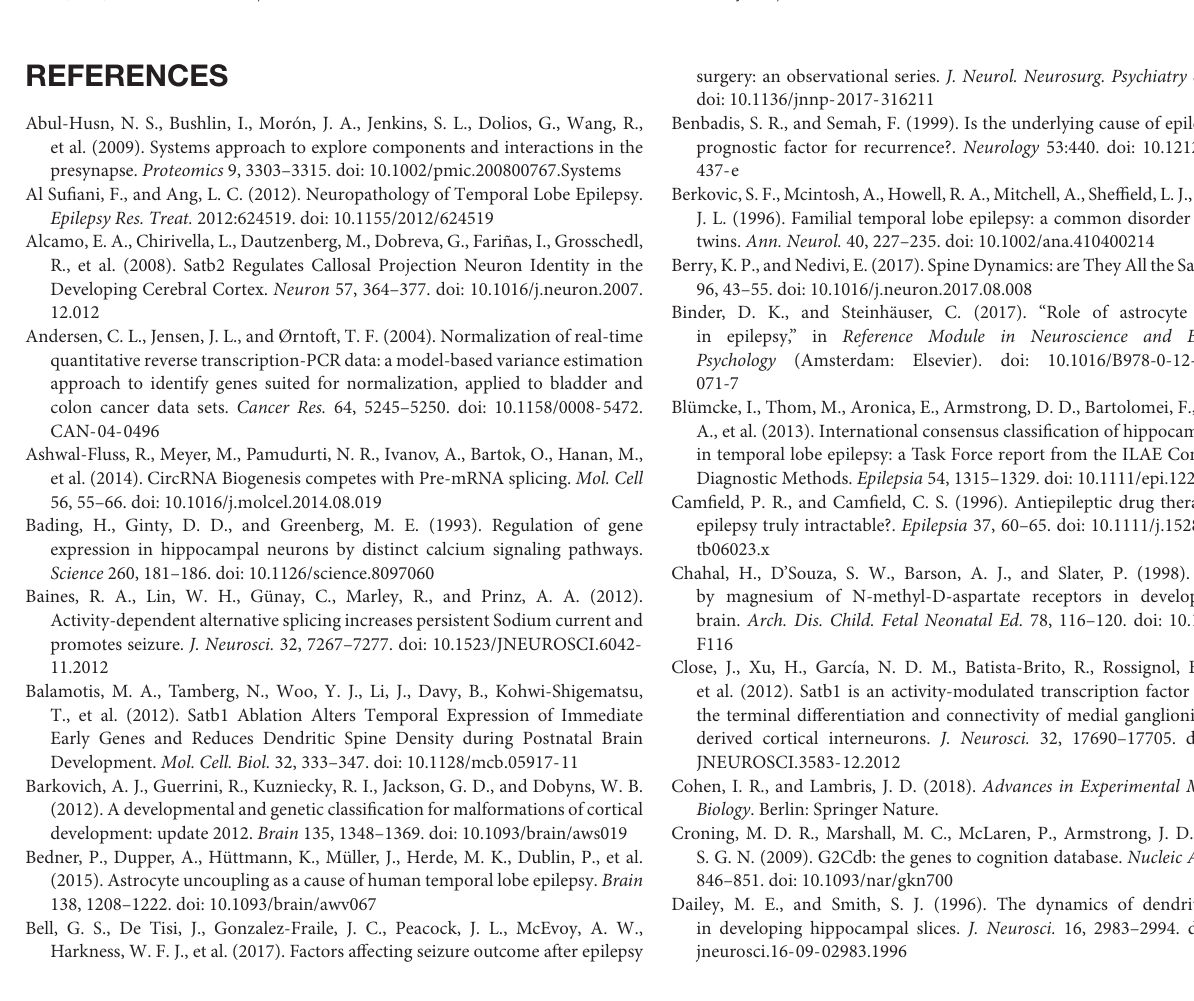
Supplementary Table 1 | DESeq2 analysis of circRNAs in mTLE versus control. List of all differentially expressed circRNAs detected after RNA-seq and DESeq2 analysis. CircRNAs are sorted by minimum p -value in mTLE (E) versus control tests (C/S). Cell colors represent the strength of significance (yellow = low, to red = high). N = 5 individuals were used per group (hg19, Homo sapiens genome assembly GRCh37; E, epilepsy; C/S, control; cx, cortex; hip, hippocampus; cyt, cytoplasm; nuc, nucleus; w0, mTLE non-HS patients; w4, mTLE + HS patients; padj, adjusted p -value). Supplementary Table 2 | List of oligonucleotides used in this study. Primers were designed using Primer-BLAST online software (https://www.ncbi.nlm.nih.gov/tools/primer-blast/) or obtained from literature (mouse circ_Homer1) (You et al., 2015), and purchased from IDT-DNA. The following criteria were met during primer design: 18–30 bp length, 50–65 ◦ C melting temperature (Tm), 40–65% %G/C content, minimum of self-complementary regions and amplicon size ≤ 250 bp. Supplementary Table 3 | NormFinder analysis to identify genes for normalization. NormFinder ( ∗ .xla, MS Excel 2003 v0.953) was used to determine the most stable normalization gene(s) to be used in RT-qPCR assays aiming to assess expression changes between controls and mTLE patients (human) or saline- and KA-injected animals (mouse). The most optimal gene, or combination of genes, is determined by their stability value: the lower this value, the more stable the gene or gene combination. Transformed Ct values were used in the analysis. tbb-2 from Caenorhabditis elegans (c.e.) was used as a spike-in to control for possible artifacts during cDNA synthesis (E1-E7, human mTLE; C1-C7, controls; KA1-KA33, KA-injected mice; Sal4-36, saline-injected mice; tbb-2, tubulin beta-2 chain; ICK, intracortical kainate).